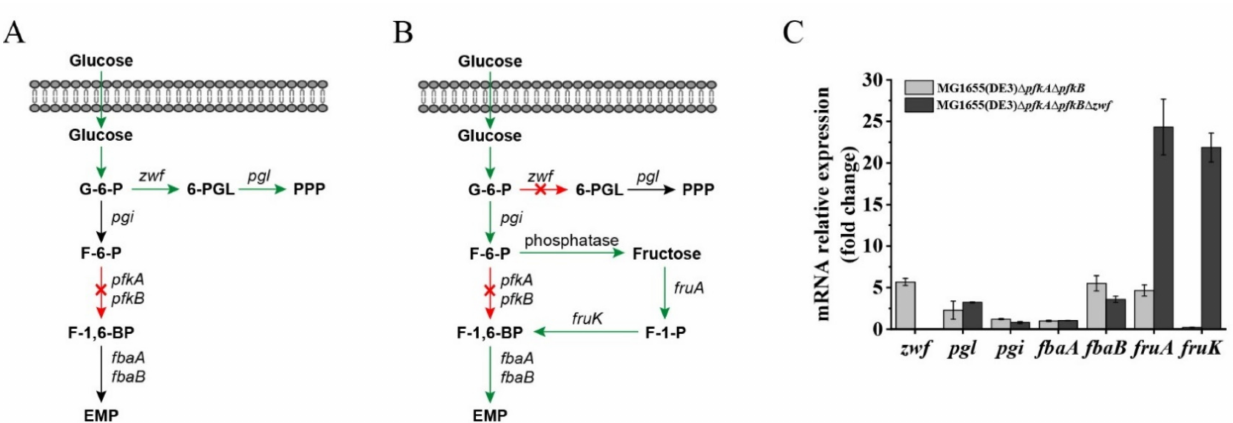
Figure 3. Gene expression and glucose utilization patterns of MG1655(DE3) ∆ pfkA ∆ pfkB and MG1655(DE3) ∆ pfkA ∆ pfkB ∆ zwf cultivated in M9s+glucose medium. Schematic diagrams of proposed glucose utilization patterns of ( A ) MG1655(DE3) ∆ pfkA ∆ pfkB and ( B ) MG1655(DE3) ∆ pfkA ∆ pfkB ∆ zwf (F-1-P bypass); ( C ) qPCR results showing the mRNA expression of genes related to G-6-P, F-6-P and F-1,6-BP metabolism in MG1655(DE3) ∆ pfkA ∆ pfkB and MG1655(DE3) ∆ pfkA ∆ pfkB ∆ zwf . 6-PGL, 6-phosphogluconolactone; pgl , 6-phosphogluconolactonase gene; F-1-P, fructose-1-phosphate; pgi , glucose-6-phosphate isomerase gene; fruA , fructose-specific PTS multiphosphoryl transferase gene; fruK , 1-phosphofructokinase; fbaA , fructose-bisphosphate aldolase gene (class 2); fbaB , fructose- bisphosphate aldolase gene (class